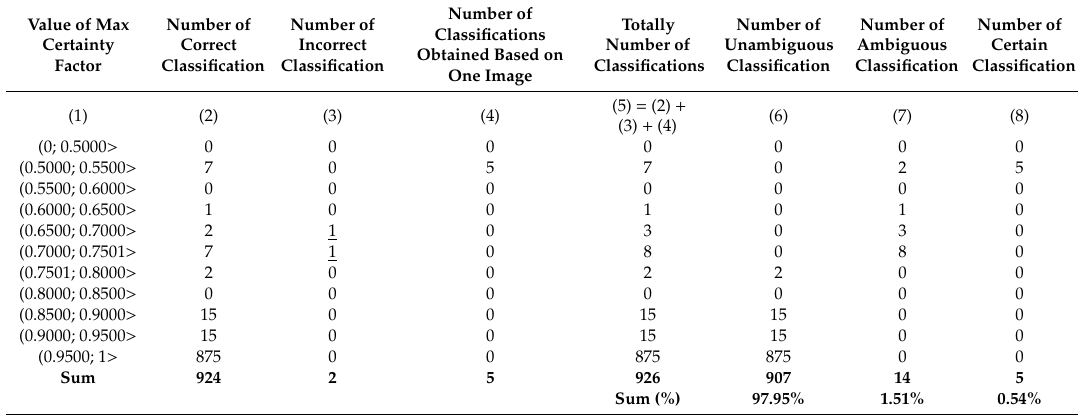
Table 7. Results of apple variety classification using the proposed method.